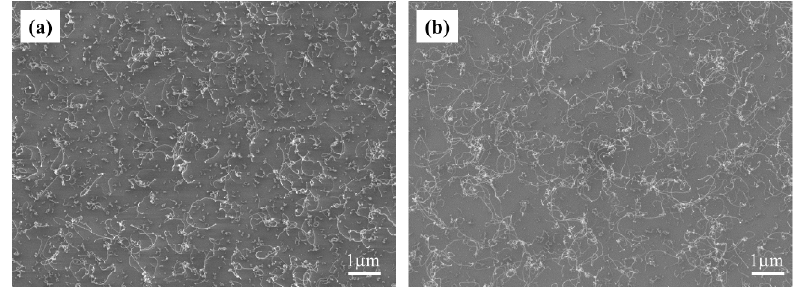
Figure 2 . The surface morphology after the CNT growth with ( a ) and without ( b ) hydrogen treatment.